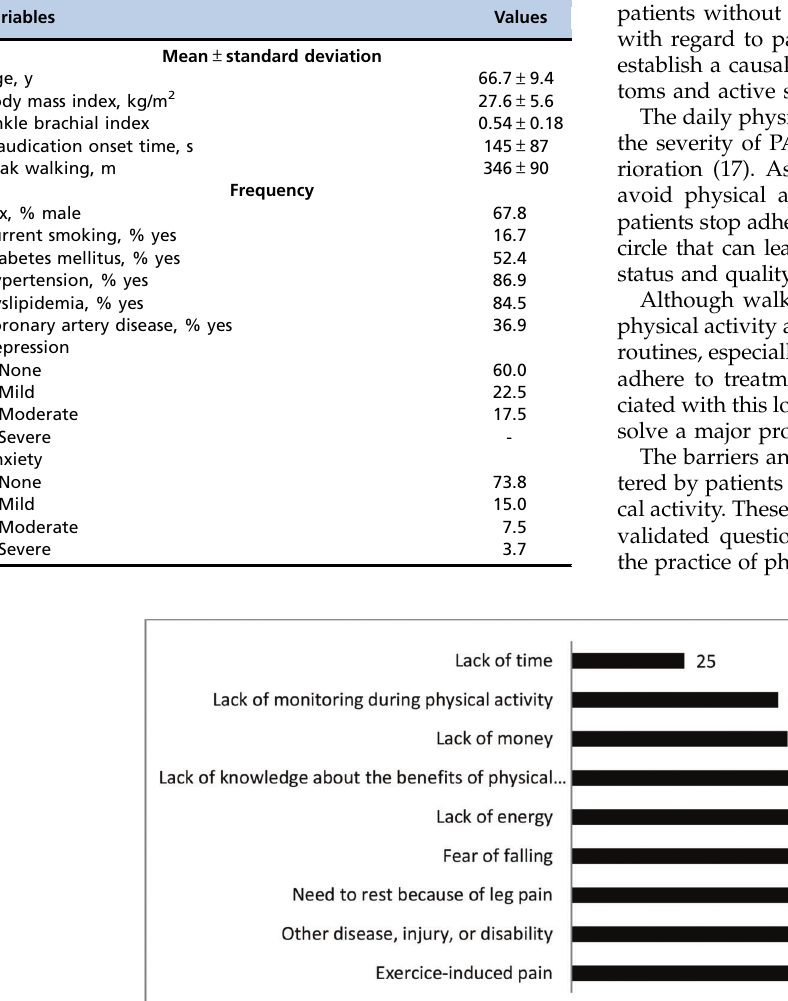
Table 1 - The characteristics of the sample (n=113).